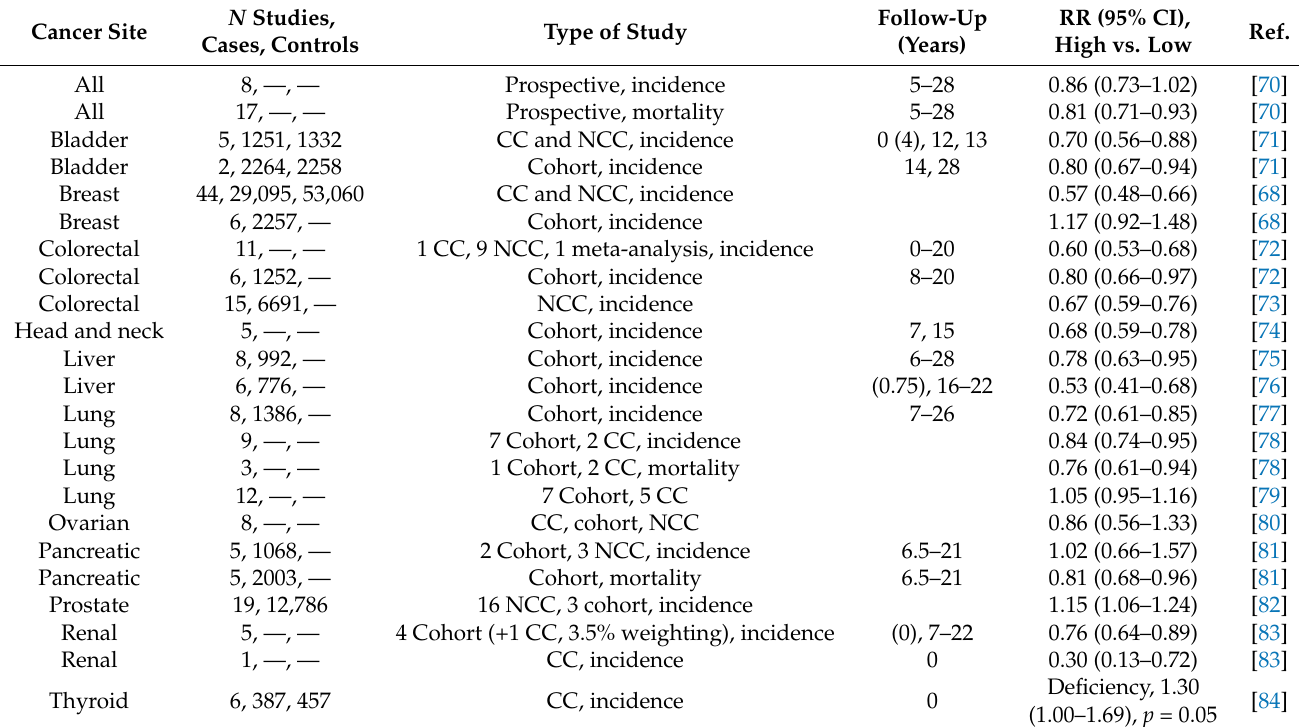
Table 5. Meta-analyses of observational studies of incidence risk of individual cancer sites related to serum 25(OH)D